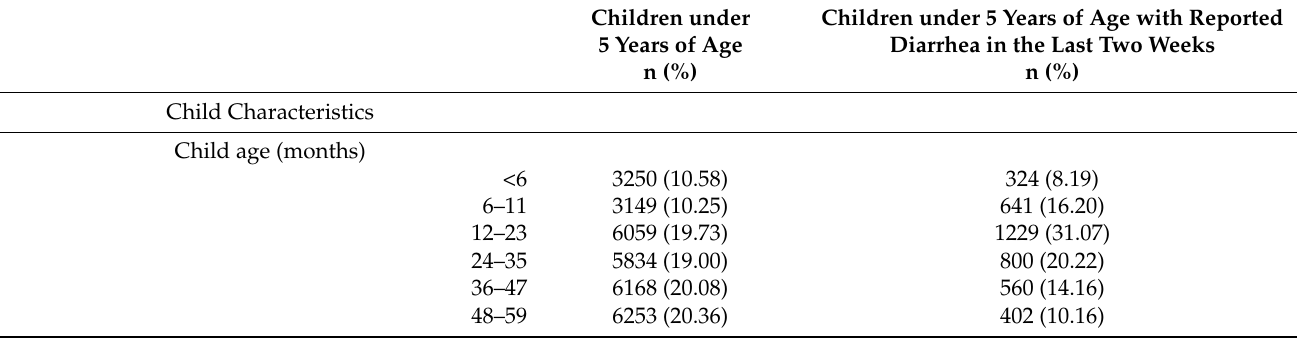
Table 1. Child, maternal, and household characteristics of children under 5 years of age included in the 2018 Nigeria DHS (N = 30,713) and characteristics of the sub-sample of children under 5 years of age for whom mothers/caregivers reported diarrhea during the 2 weeks prior the survey (N = 3956). Children under Children under 5 Years of Age with Reported 5 Years of Age Diarrhea in the Last Two Weeks n (%) n